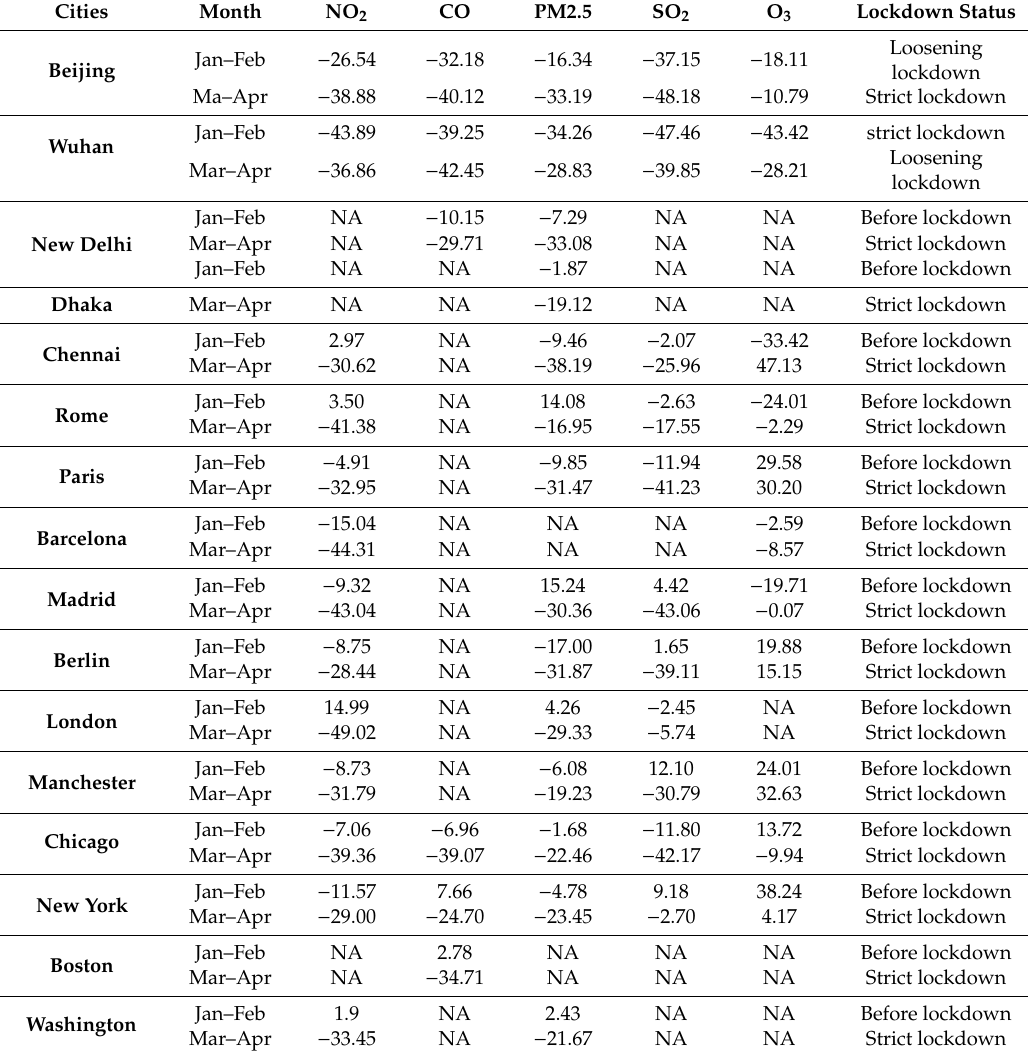
Table 3. Percentage changes in NO 2 , CO, SO 2 , O 3 , and PM2.5 concentrations when comparing 2020 lockdown period to the same period in 2015–2019 across the di ff erent global metropolitan